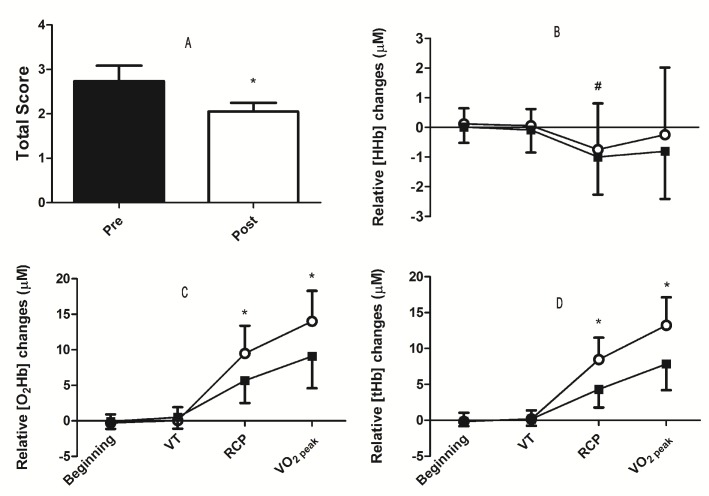
Exercise induced results in brain hemodynamics and craving.Legend: A: Craving Scale; B: Deoxyhemoglobin; C: Oxyhemoglobin D: Total hemoglobin; VT: Ventilatory threshold; RCP: Respiratory compensation point. *significantly different compared to control (C: p = 0.00005 and p = 0.00005; D: p = 0.00001 and p = 0.001).#significantly different compared to beginning (SUD; p = 0.001; CG; p = 0.004) and VT (SUD; p = 0.007; CG;p = 0.014).